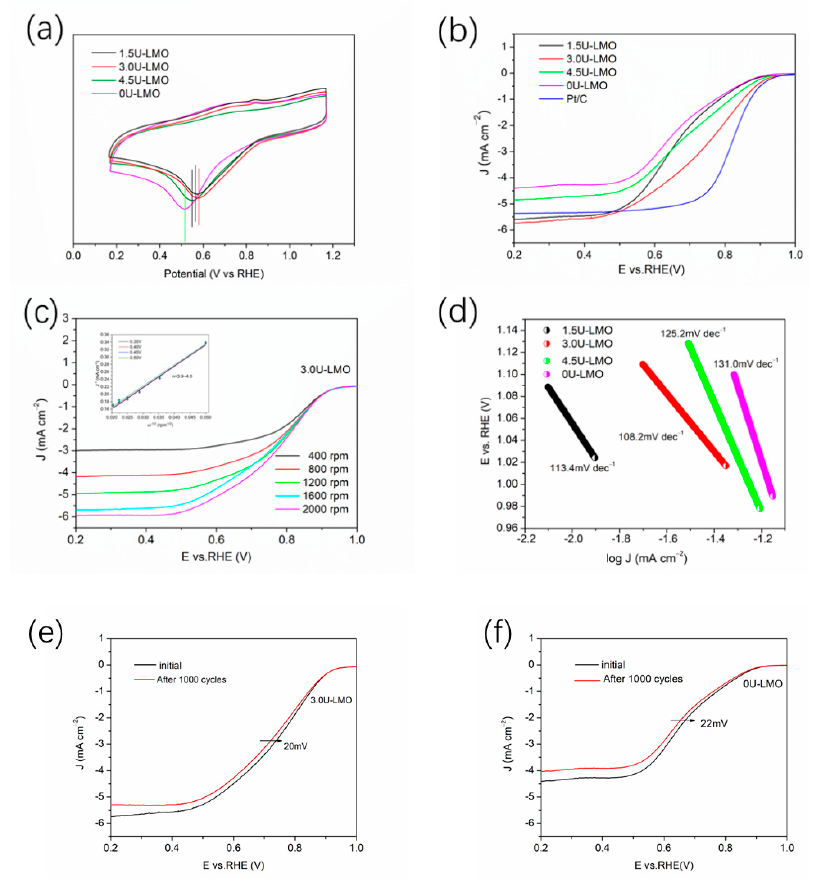
Figure 6. ( a ) CV curves and ( b ) LSV curves of xU-LMO (x = 0, 1.5, 3.0, and 4.5) catalysts, ( c ) LSV curves of 3.0U-LMO catalyst measured in the speed range 400–2000 rpm (inset: K-L plots for 3.0U- LMO catalyst at various potentials), ( d ) Tafel plots of xU-LMO (x = 0, 1.5, 3.0, and 4.5) catalysts, and LSV curves of ( e ) LMO and ( f ) 3.0U-LMO at 1600 rpm before and after 1000 consecutive cycles.